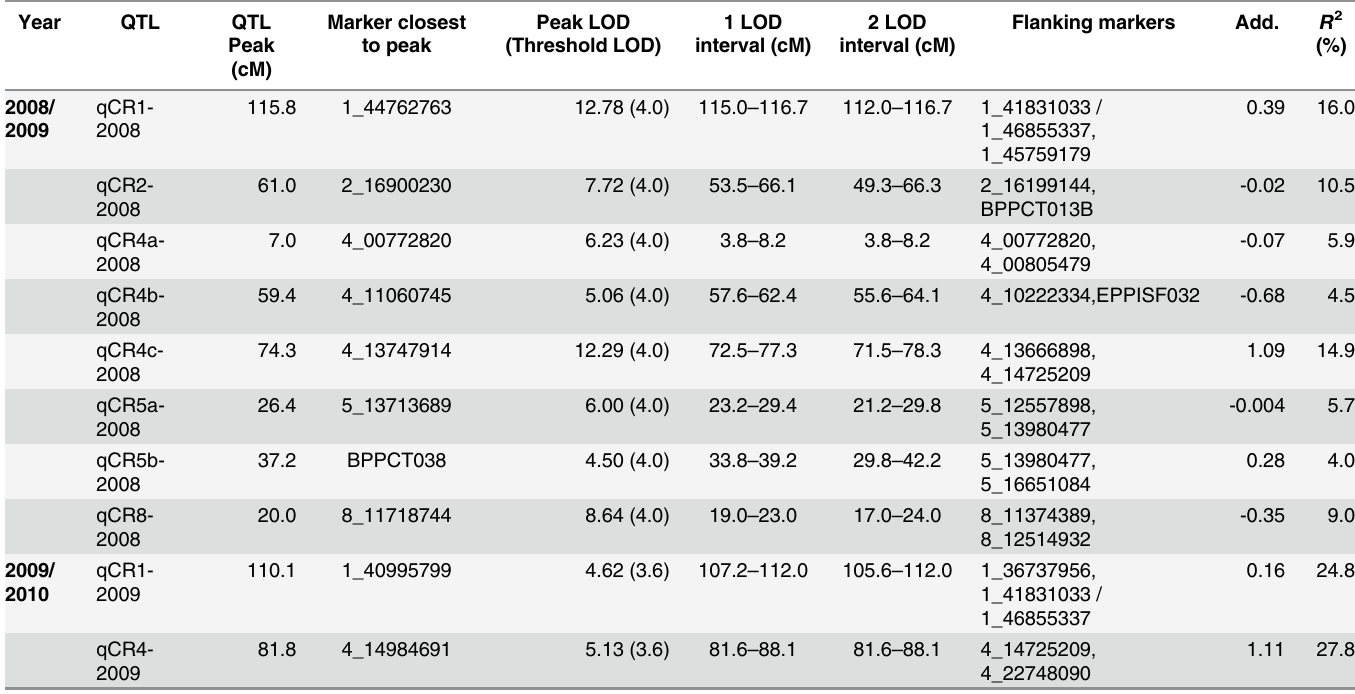
Table 2. Chilling requirement QTL detected in 2008/2009 and